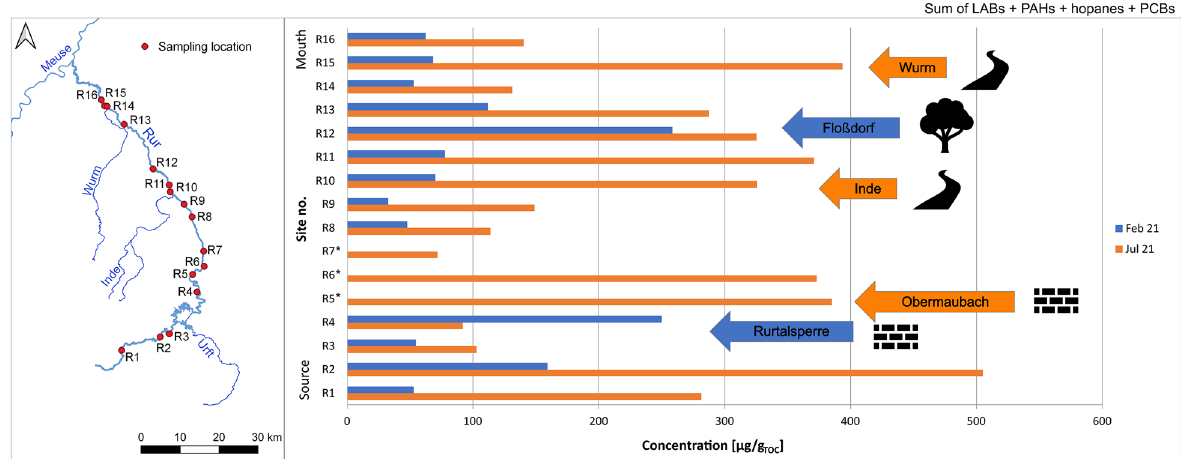
Fig. 6 Total contamination as a sum of LABs, PAHs, hopanes and PCBs in the Rur catchment. Samples have been taken after two flood events in January/February and July 2021. Important structural measures, (re)naturalized areas and tributaries are highlighted. (*) R5 to R7 were not sampled in